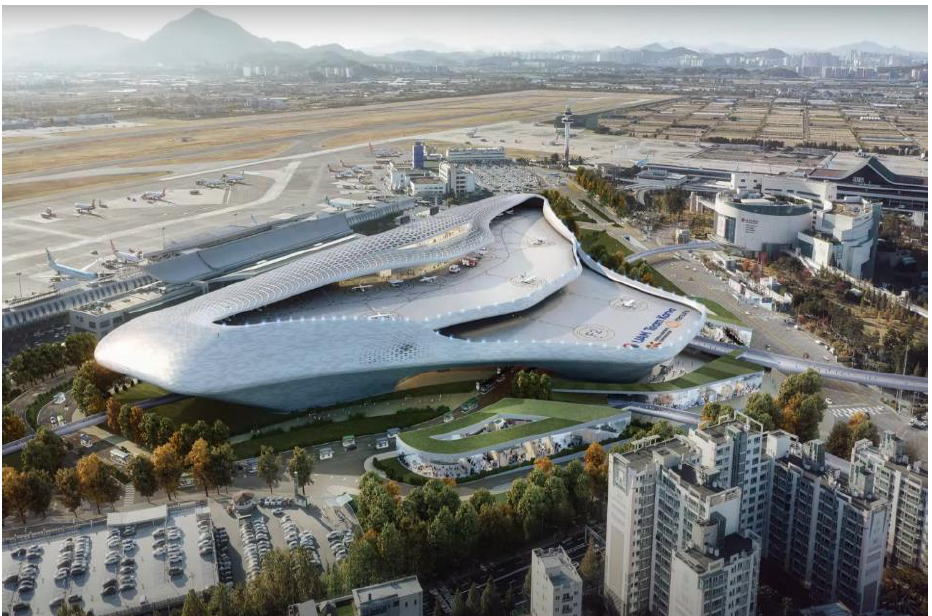
Figure 15. Gimpo Airport vertihub design of the Korea Airport Corporation [21].